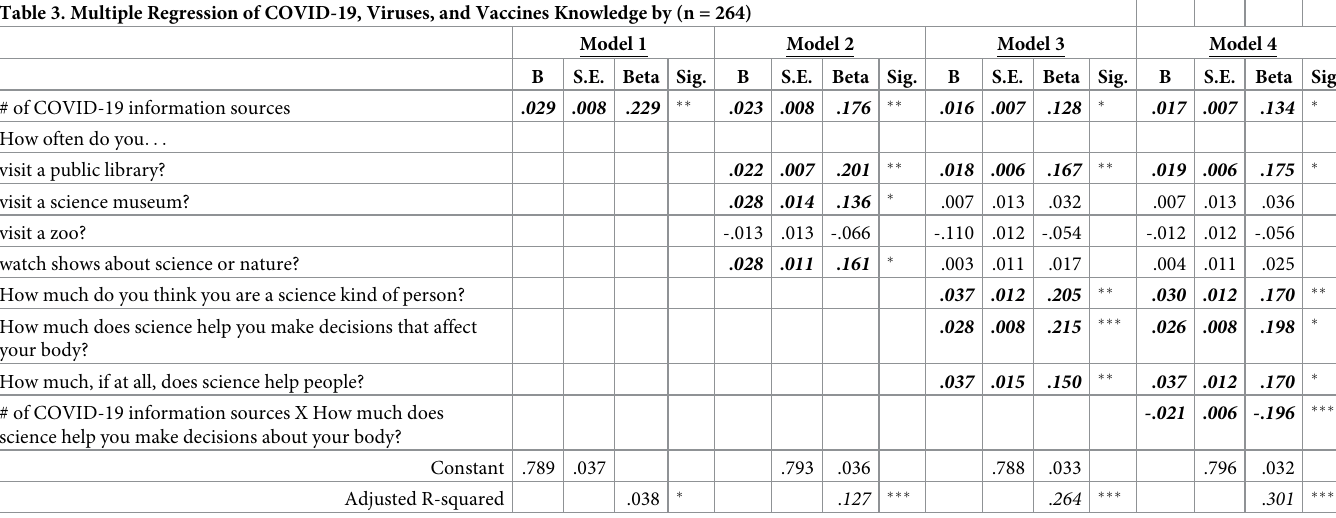
Table 3. Multiple regression of COVID-19 relevant knowledge on information sources. Table 3. Multiple Regression of COVID-19, Viruses, and Vaccines Knowledge by (n =